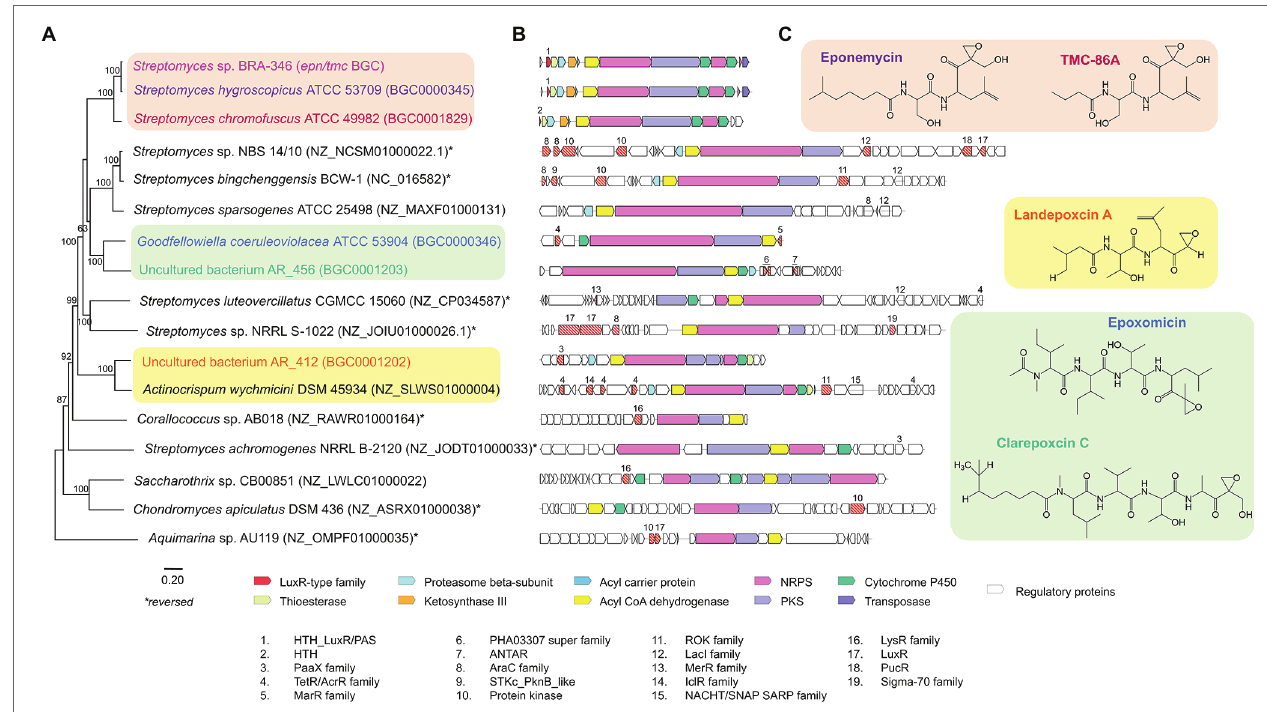
FIGURE 6 | Phylogenetic analysis of BGCs related to BRA-346 epn/tmc . (A) Maximum likelihood phylogenetic tree based on the alignment of the 16 retrieved BGCs related to BRA-346 epn/tmc BGC. (B) Schematic representation of the 17 BGCs and (C) their related biosynthetic products. BGCs with experimentally validated biosynthetic products are highlighted. ORFs predicted as regulatory proteins are numbered and